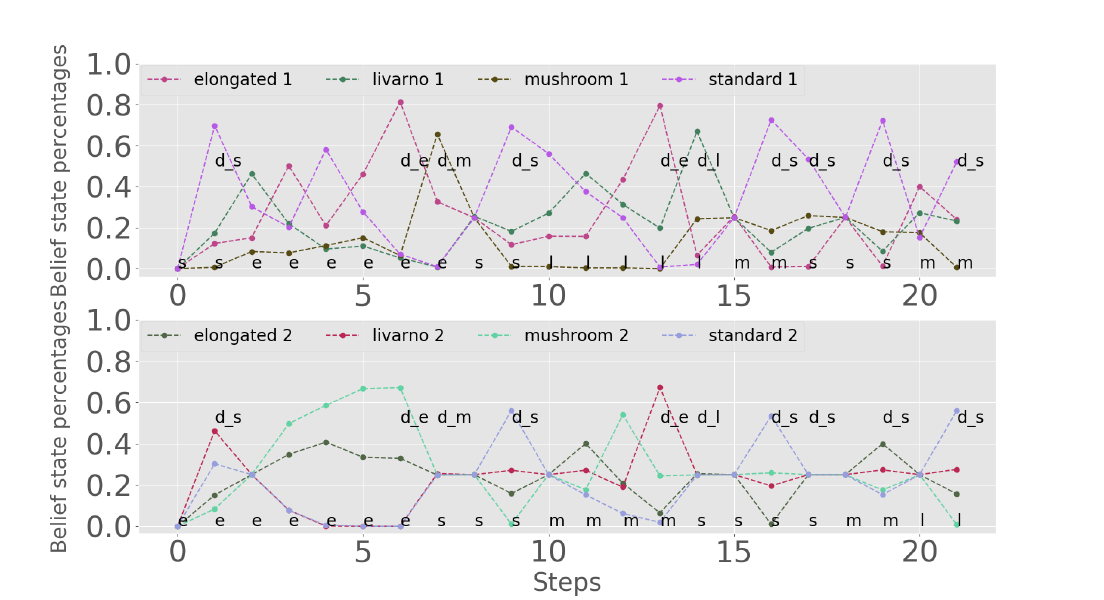
Figure 10. Belief state evolution when observing two positions from the conveyor belt.